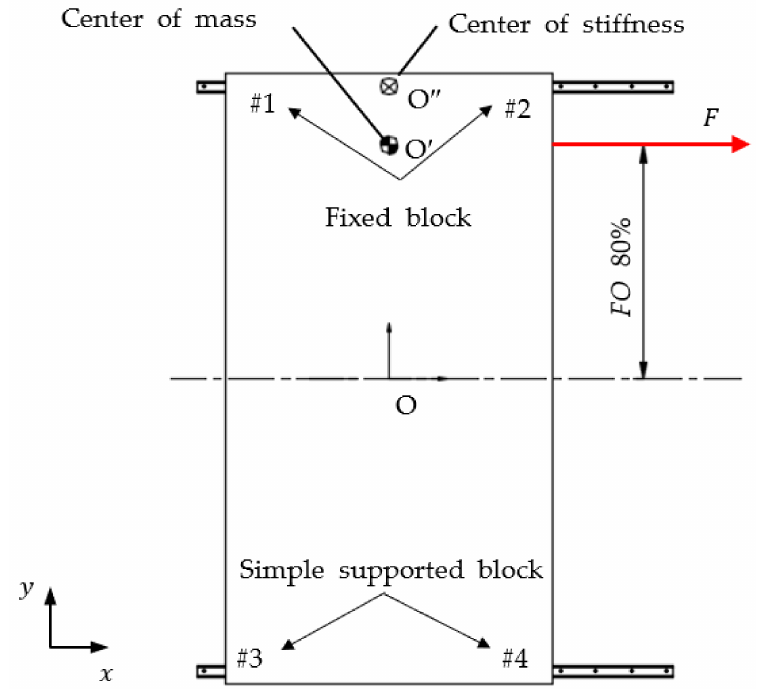
Figure 22. Modified platform for minimization of yaw